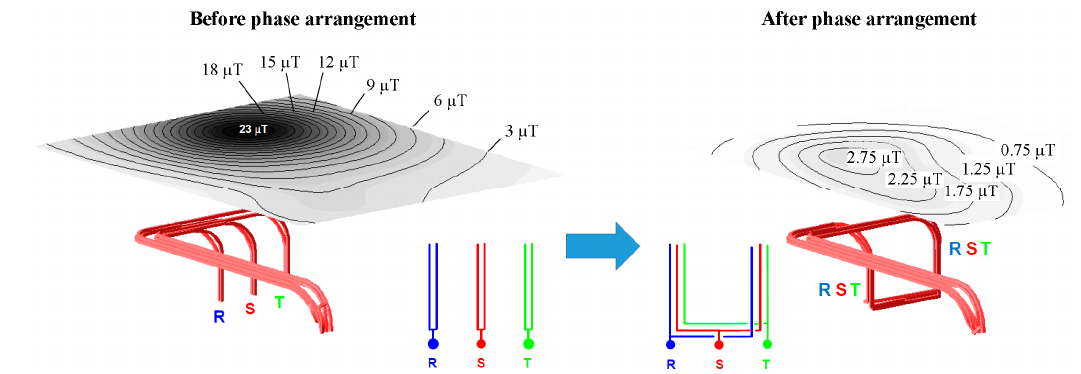
Figure 6. MF before and after mixing phases on the LV connections in a MV/LV substation (based on [13], CIGRÉ 2009).